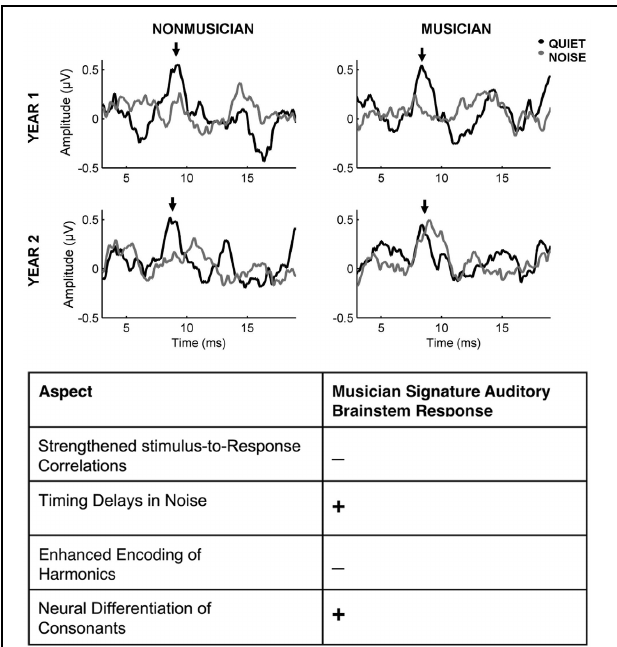
FIGURE 1 | Emerging neural enhancements in the encoding of sound in preschool-aged musicians with continued musical training. Top : Representative auditory brainstem onset responses to /da/ in quiet and /da/ in noise for musician and non-musician participants who were tested initially and returned for testing after one year of continued musical training or alternative enrichment activities. Musicians have more resilient responses in noise after an additional year of musical training and development compared to non-musician counterparts (adapted from Strait et al., 2013b). Bottom : Preschool-aged musicians do not yet demonstrate the full “musician signature” enhancements seen in adults but aspects of enhanced neural encoding are beginning to emerge, as indicated by a + (Strait et al., 2013b, 2012b for review see Strait and Kraus, 2013).